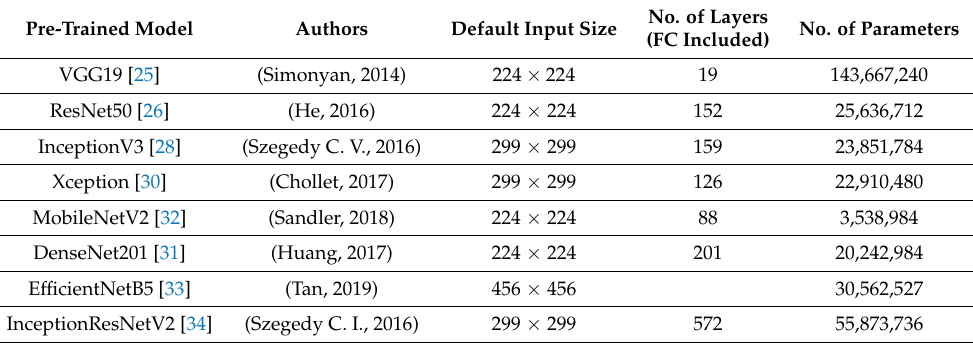
Table 1. Information of some pre-trained models for image classification tasks. FC stands for fully connected layer.